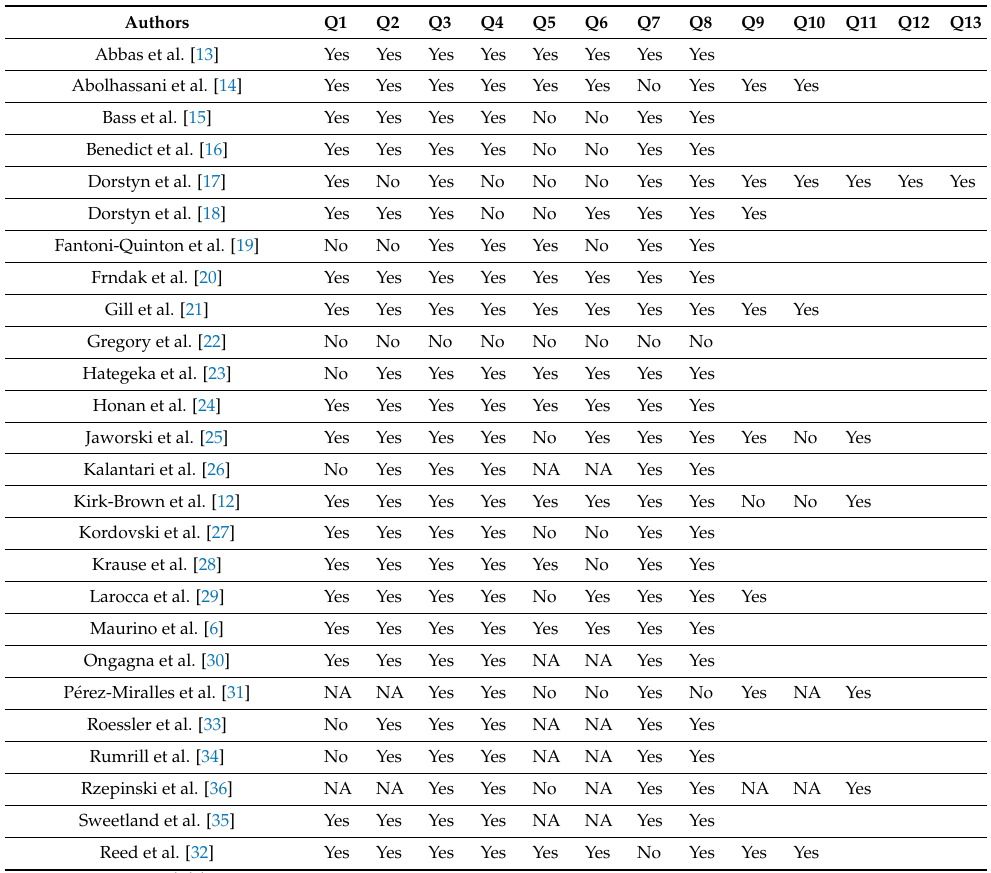
Table 3. Quality appraisal of the studies included in the